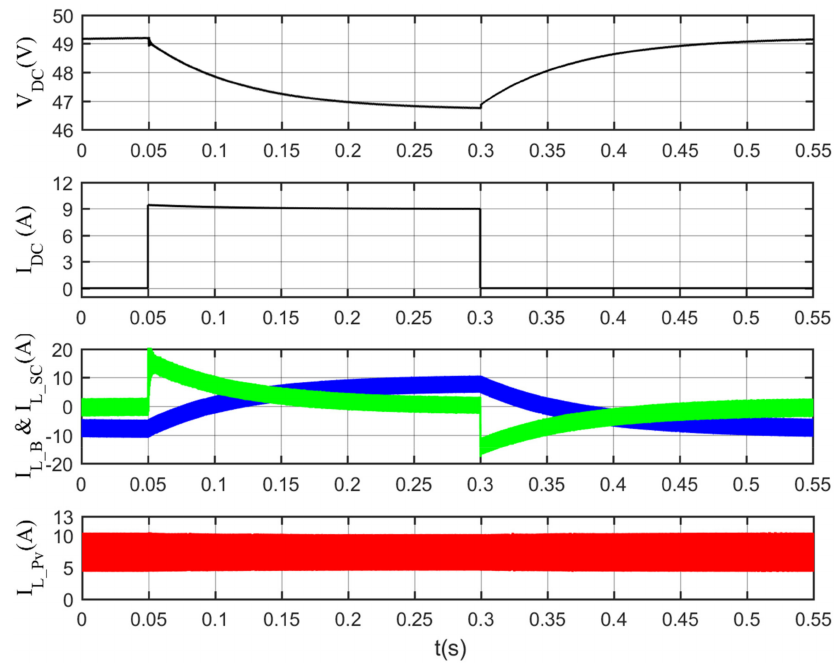
Figure 8. Simulation results for the single droop control scheme when the load is changed from no-load to 5.2 Ω (full nanogrid load) and back to